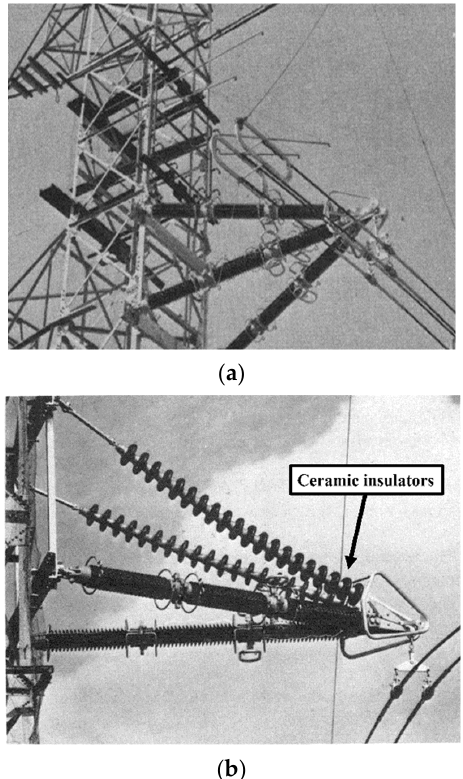
Figure 3. ( a ) Quadruple ‐ type and ( b ) twin ‐ arm ceramic insulator [20].